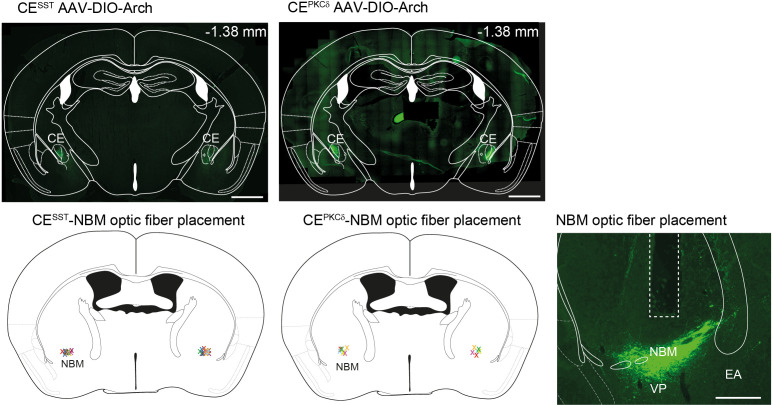
Histological verification of the optogenetic CE–NBM manipulation cohorts.CESST and CEPKCδ injection sites of AAV-DIO-Arch/NpHR3.0-YFP (scalebar = 900 µm) (top) and optic fiber placement in NBM (scalebar = 100 µm) (bottom). Schematic placement of the optic fiber tip above the terminal field in NBM marked with ‘x’ (bottom, right).